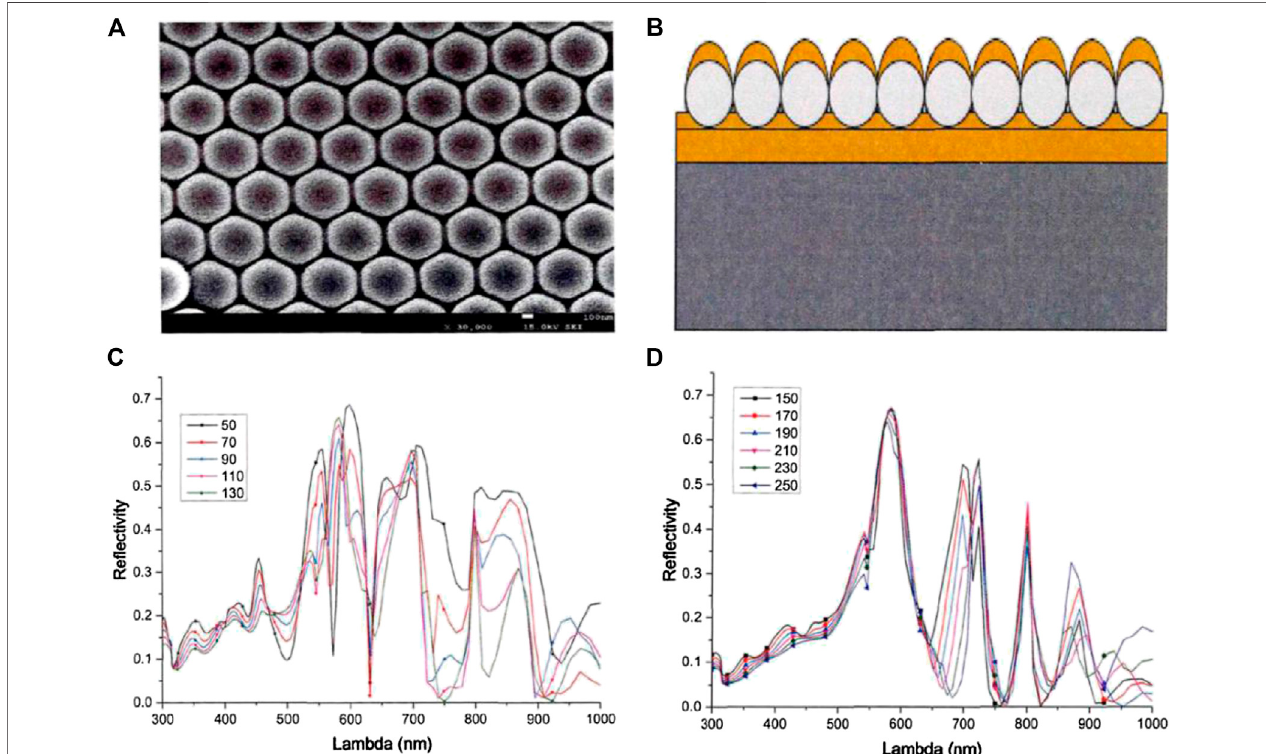
FIGURE 14 | (A) It is the SEM picture of the nano spherical. (B) Schematic diagram of nanospheres. (C, D) The dependence of re fl ectivity on wavelength with different coating thickness. Source : Reproduced from Ref. 35.